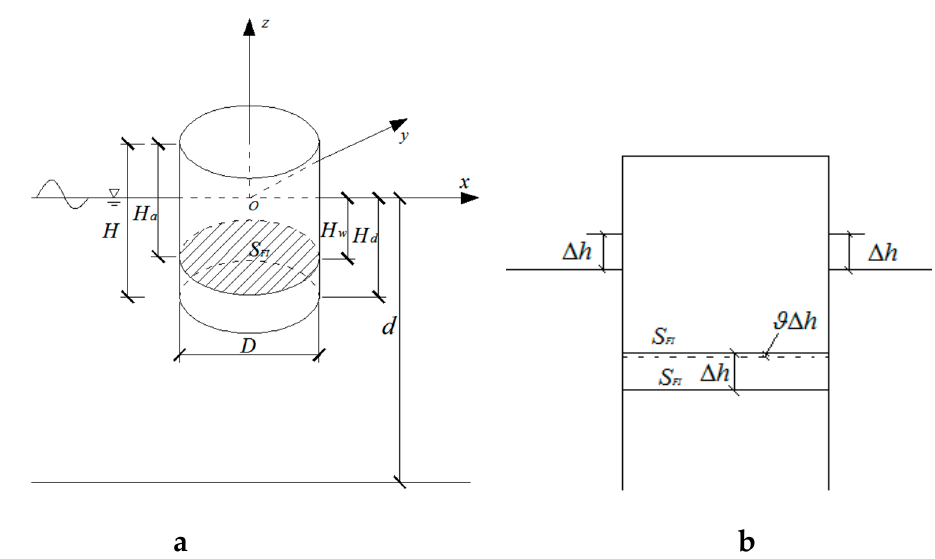
a b Figure 3. ( a ) Schematic diagram of floating state for single bucket foundation, and ( b ) vertical motion of single-bucket foundation and compression of the air cushion in the bucket.